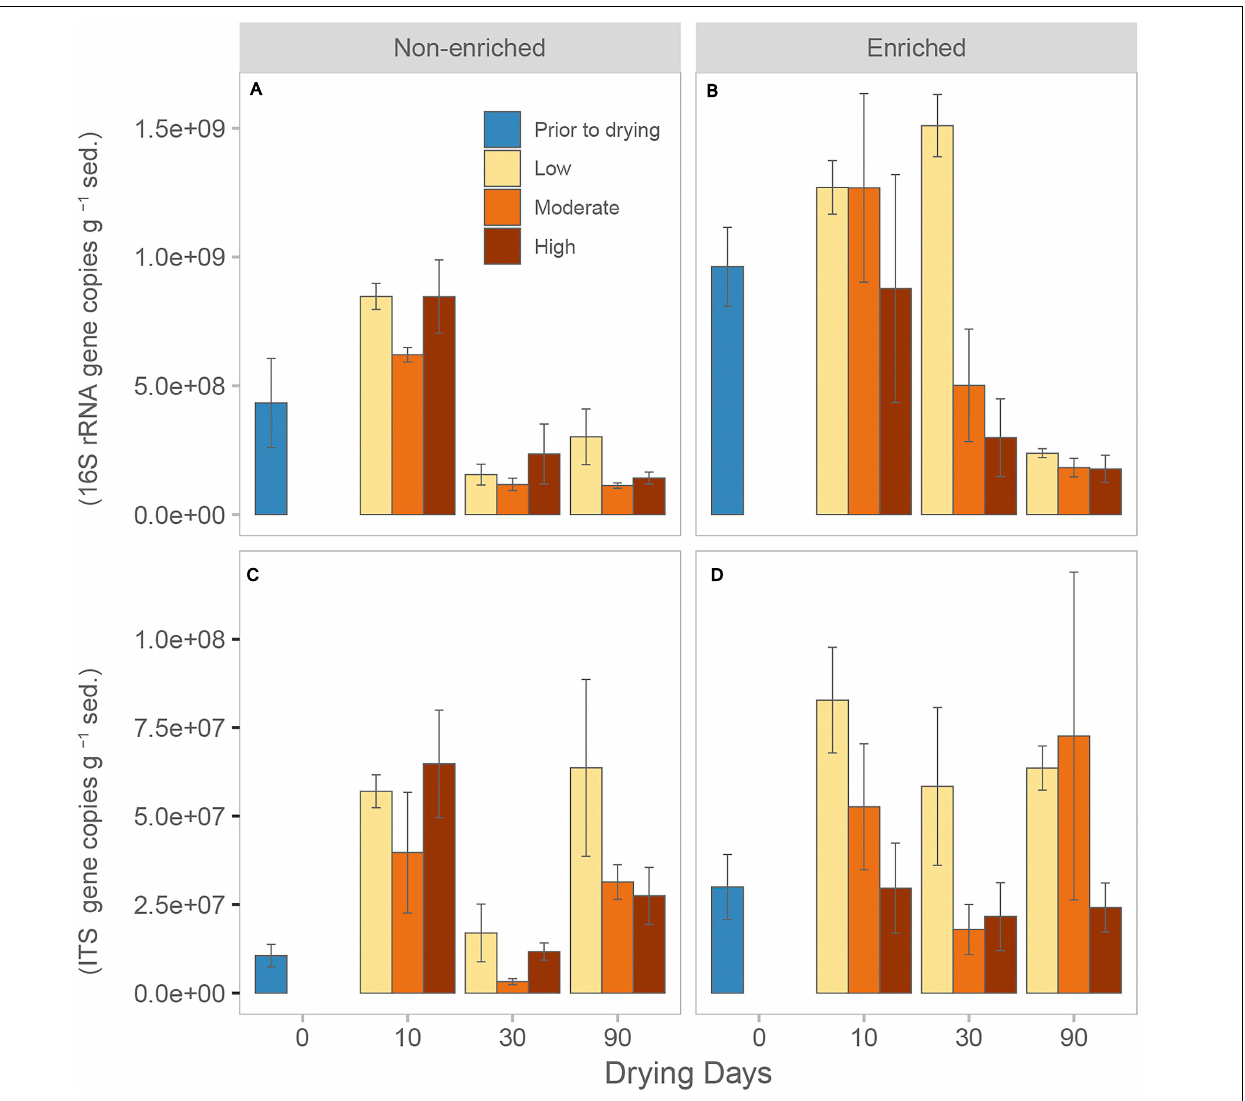
FIGURE 1 | Average (mean + SE, n = 3) number of 16S rRNA gene copies for (A) non-enriched and (B) enriched sediment, and average number of ITS gene copies for (C) non-enriched and (D) enriched sediment under each drying intensity (low, moderate, and high) at different drying durations (0, 10, 30, and 90